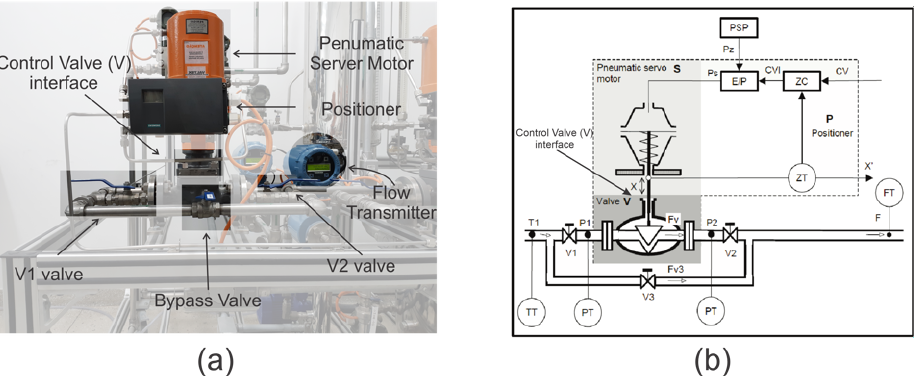
Figure 6. Similarity scheme of actuators: ( a ) AUTHOMATHIKA actuator based on ( b ) actuator model DAMADICS